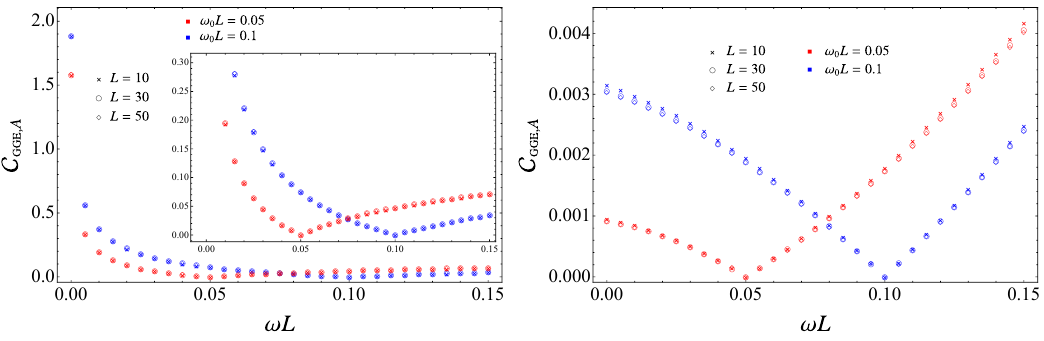
Figure 17 . Asymptotic value of C in (5.26) for a block A made by L consecutive sites in GGE ,A infinite chains in terms of ωL . The block is either in an infinite chain (left panel) or adjacent to the origin of the semi-infinite line with DBC (right